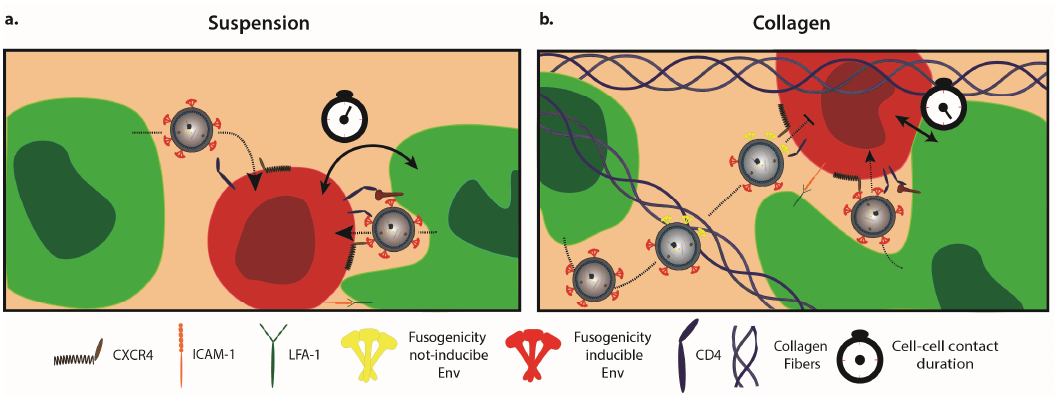
Figure 5. HIV-1 spread in suspension and 3D collagen cultures. ( a ) In suspension cultures, virions can be transmitted to uninfected target cells via both cell-free and cell-associated modes of